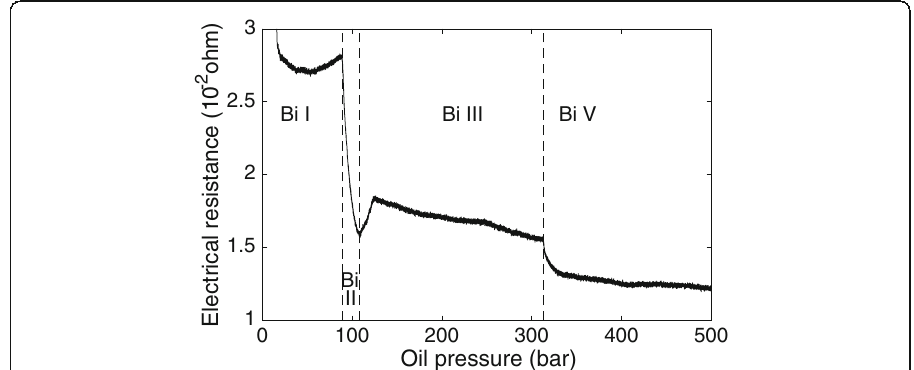
Fig. 4 Electrical resistance of bismuth (Bi) measured in-situ during a high pressure experiment